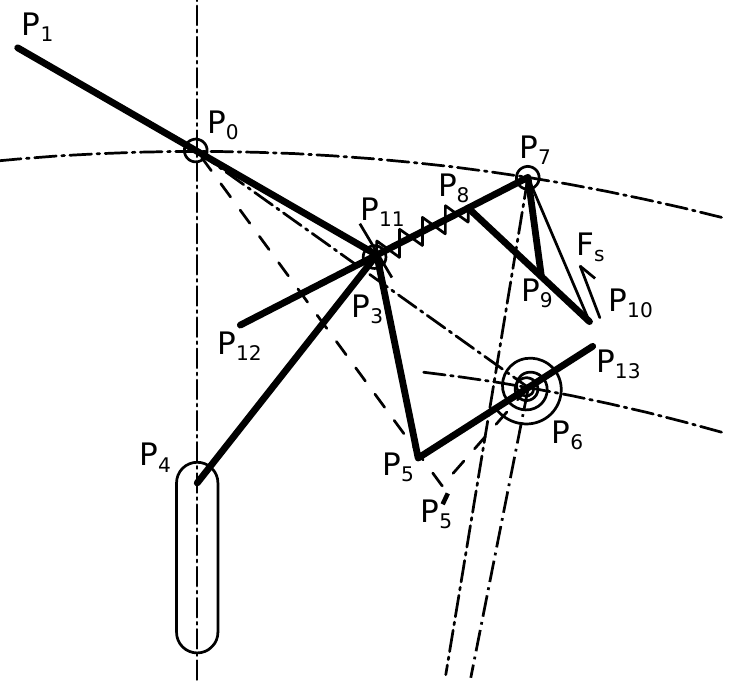
Figure 11. Schematic view of chain 3 and chain 2 for SMA force